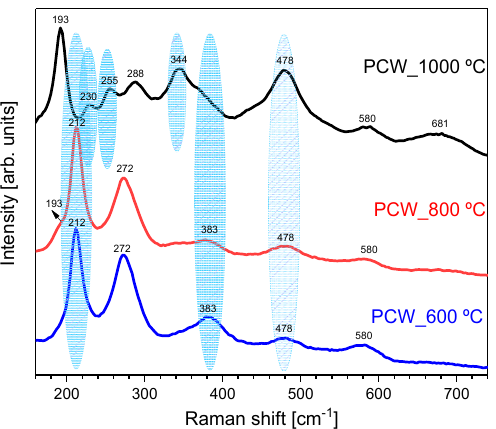
Figure 3. Raman spectroscopy of samples heat-treated at 600, 800, and 1000 °C.